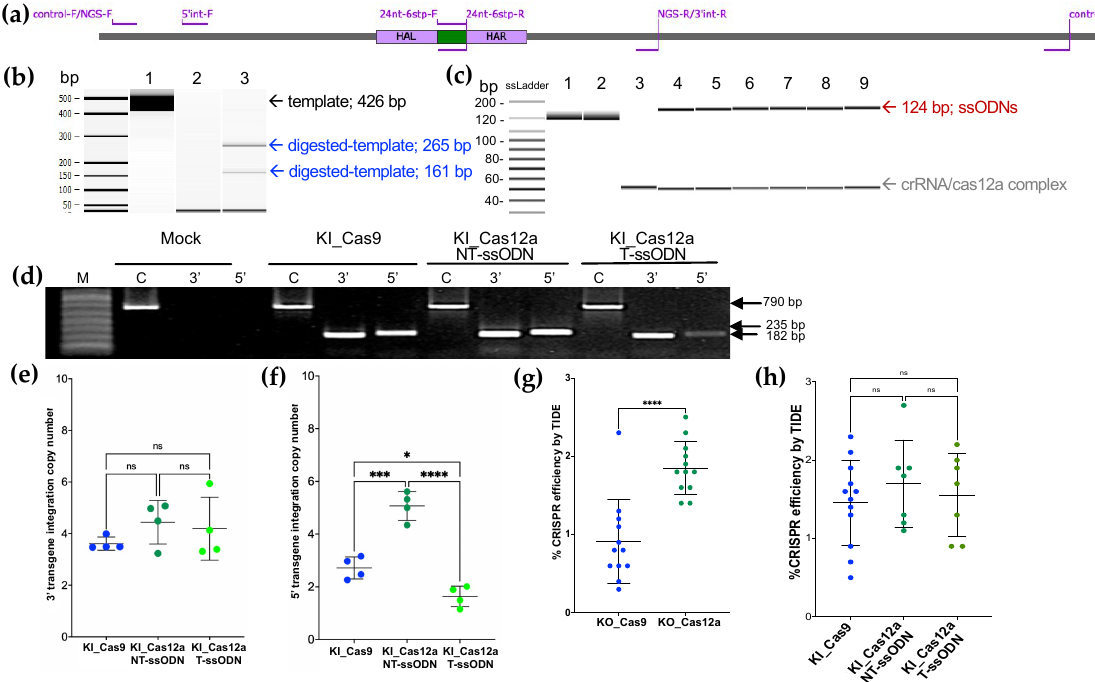
Figure 2. Knock-in by homology-directed repair: ( a ) The location of primers used for 5 (cid:48) - and 3 (cid:48) -